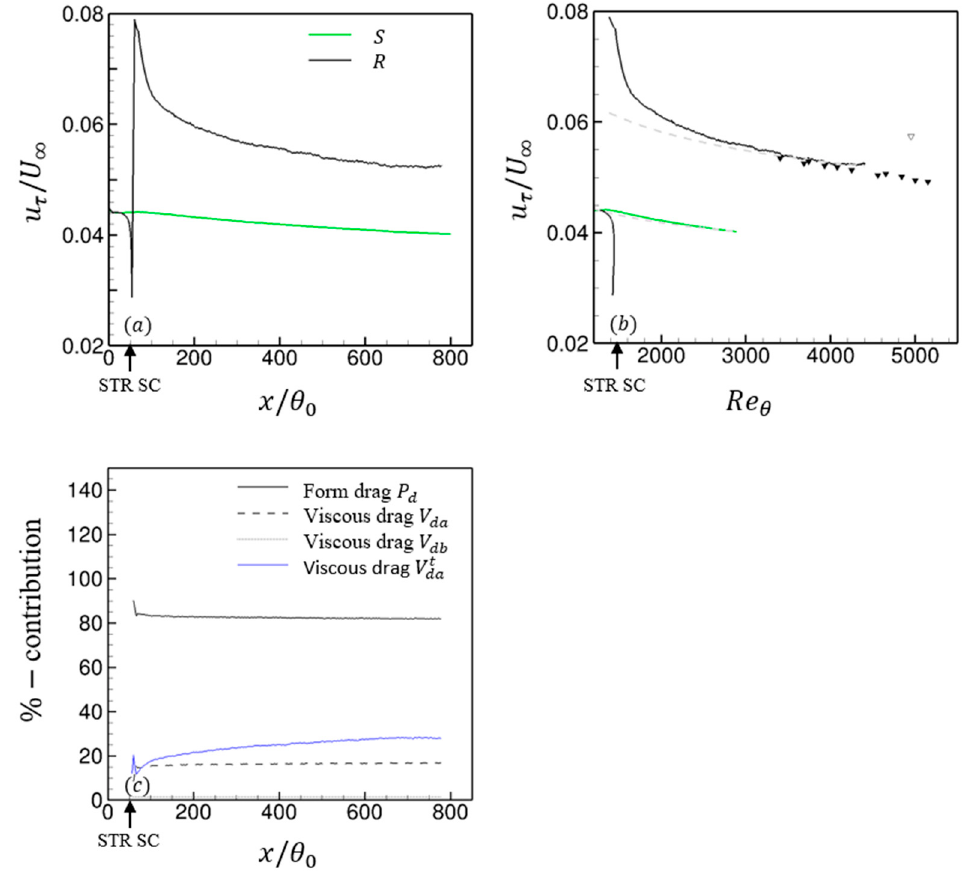
Figure 5. Streamwise variation of frictional velocity u τ along ( a ) x / θ 0 and ( b ) Re θ . Dashed lines in ( b ) represent correlation curves of the form u τ − 2.6 (case R ). Filled symbols in ( b ): experiment by [31]; open symbol in ( b ): experiment by [32]. ( c ) Percentage contribution to skin friction C f = no-slip surfaces and V db : viscous drag due to side walls of the roughness elements. V t in ( c ) indicates the fractional contribution to V da by horizontal no-slip surfaces at the top of the roughness elements ( y = k ). The vertical arrows on the x –axes indicate the location of the STR step change